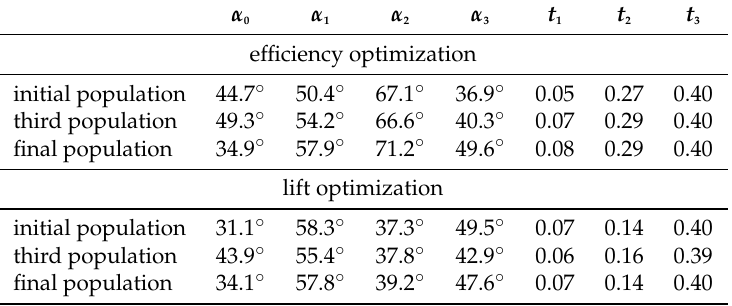
Table 3. Parameters describing the pitching motions of the best individuals of the first, third and final generation for the genetic algorithm efficiency and lift